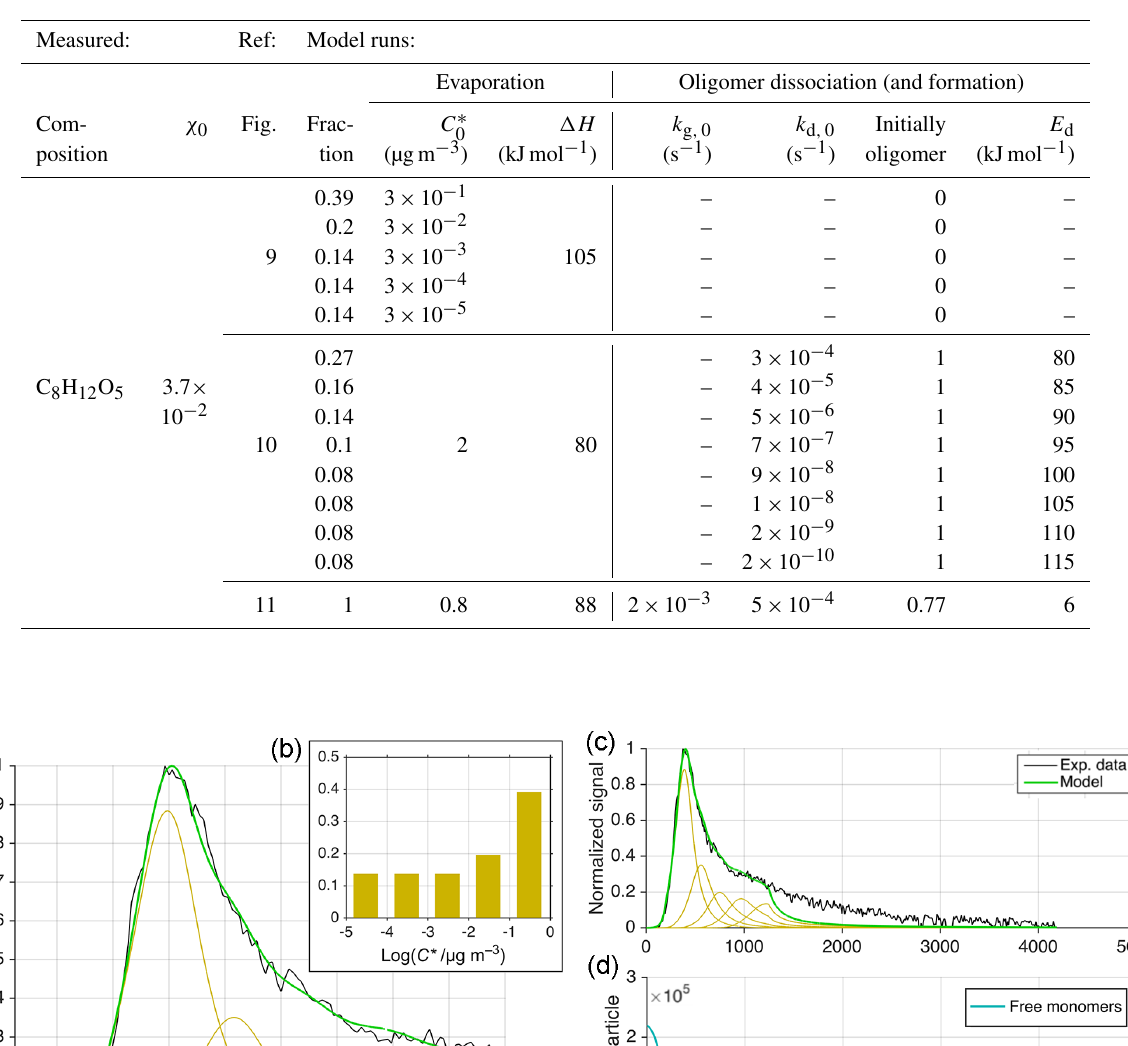
Table 2. Free parameters used for model runs in Figs. 9–11 to reproduce the C 8 H 12 O 5 thermogram obtained from an α -pinene ozonolysis (dark) SOA experiment. A particle size of 197nm was used; the evaporation coefficient was always α = 1. The Raoult term at the start of desorption ( χ 0 ) was based on observed signals (see text). Oligomerization was modeled reversibly in the case of Fig. 11 (last line), indicated by a value provided for k g , 0 and an initial oligomer fraction determined by assumed steady state initially. The activation energy for oligomerization was E g , 0 = 0kJmol − 1 .